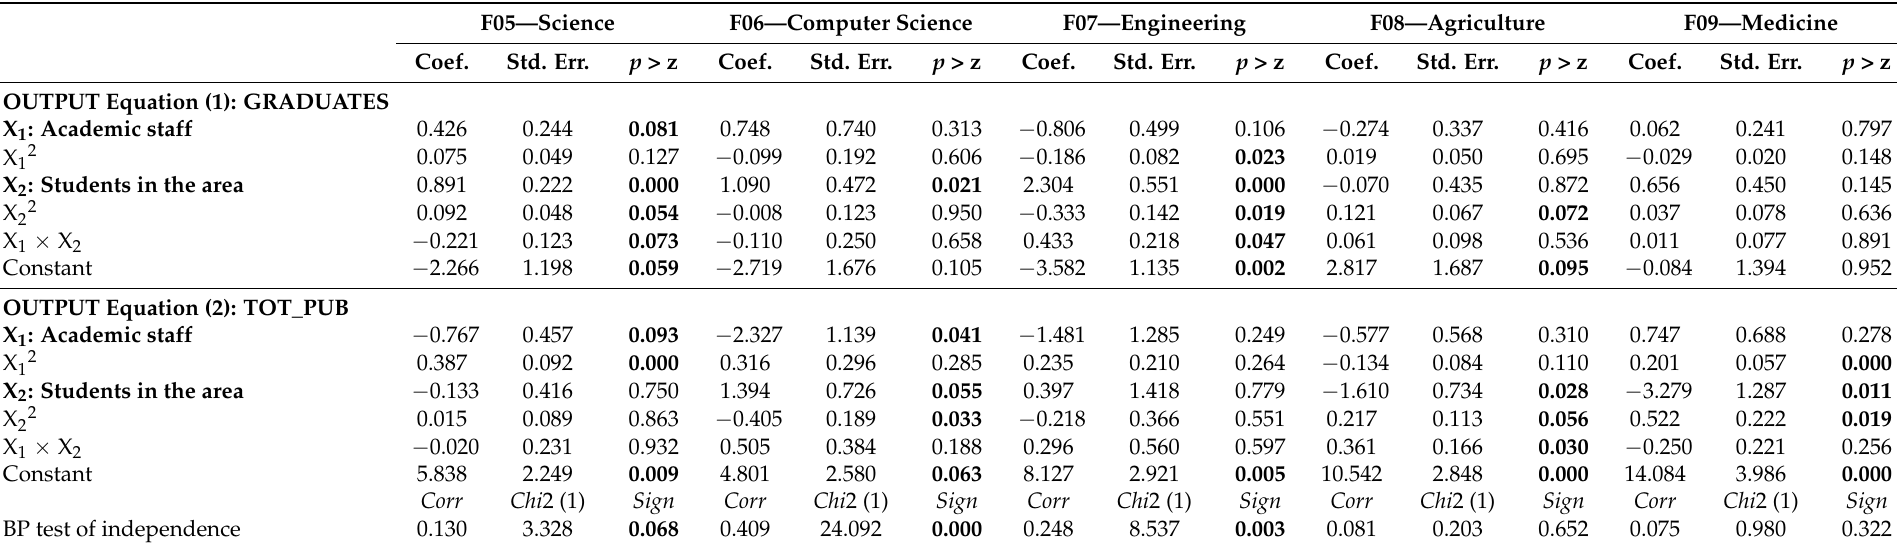
Table 2. SUR Estimates: reduced Translog function.